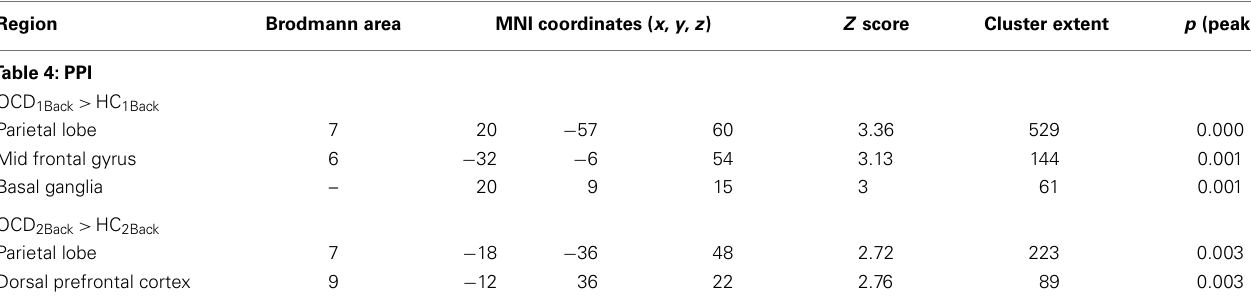
Table 4 |The table provides information regarding clusters of significant and significant peaks showing dysfunctional network profiles in OCD (compared to HC) at each level of memory load (Figure 4)